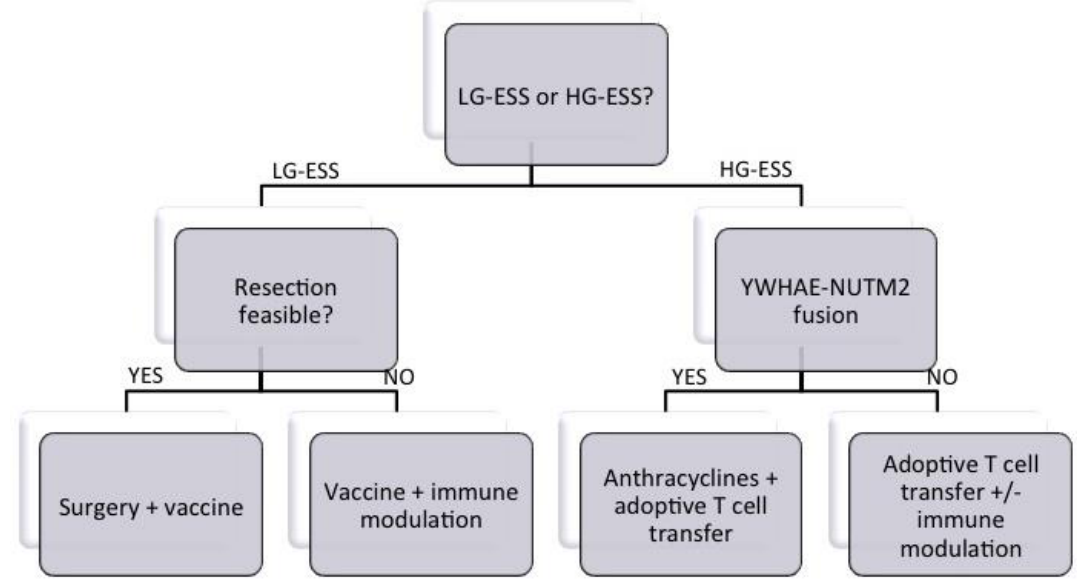
Figure 2. Proposed decision tree for treatment allocation to ESS patients.